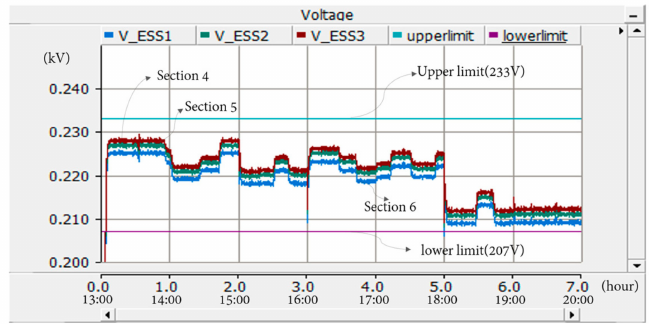
Figure 20. Analysis of the customer voltage characteristic by ESS and SVR operation (lower limit).